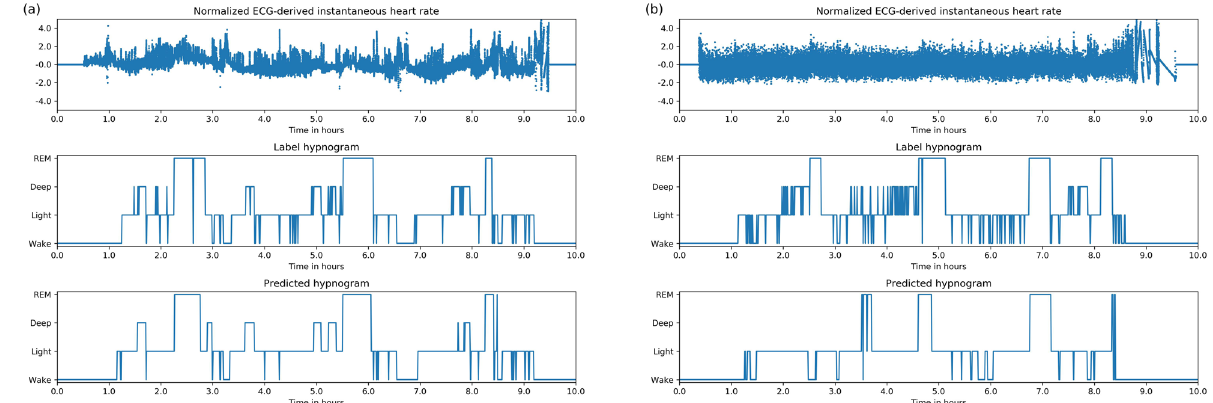
Fig. 7 More example hypnograms. a Hypnogram of an apneic subject (AHI = 70). Hypnogram shows similar 60 – 90 min sleep cycles but the cycles often contain signi fi cant wake periods. b Hypnogram with poor input data quality. Predicted hypnogram gets some of the structure correct but incorrectly classi fi es many deep and REM epochs.